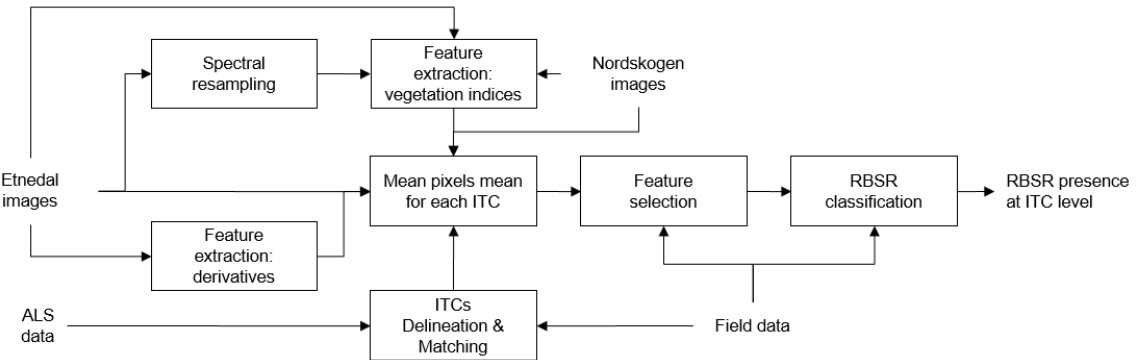
Figure 2. Scheme of the processing steps adopted in this study.